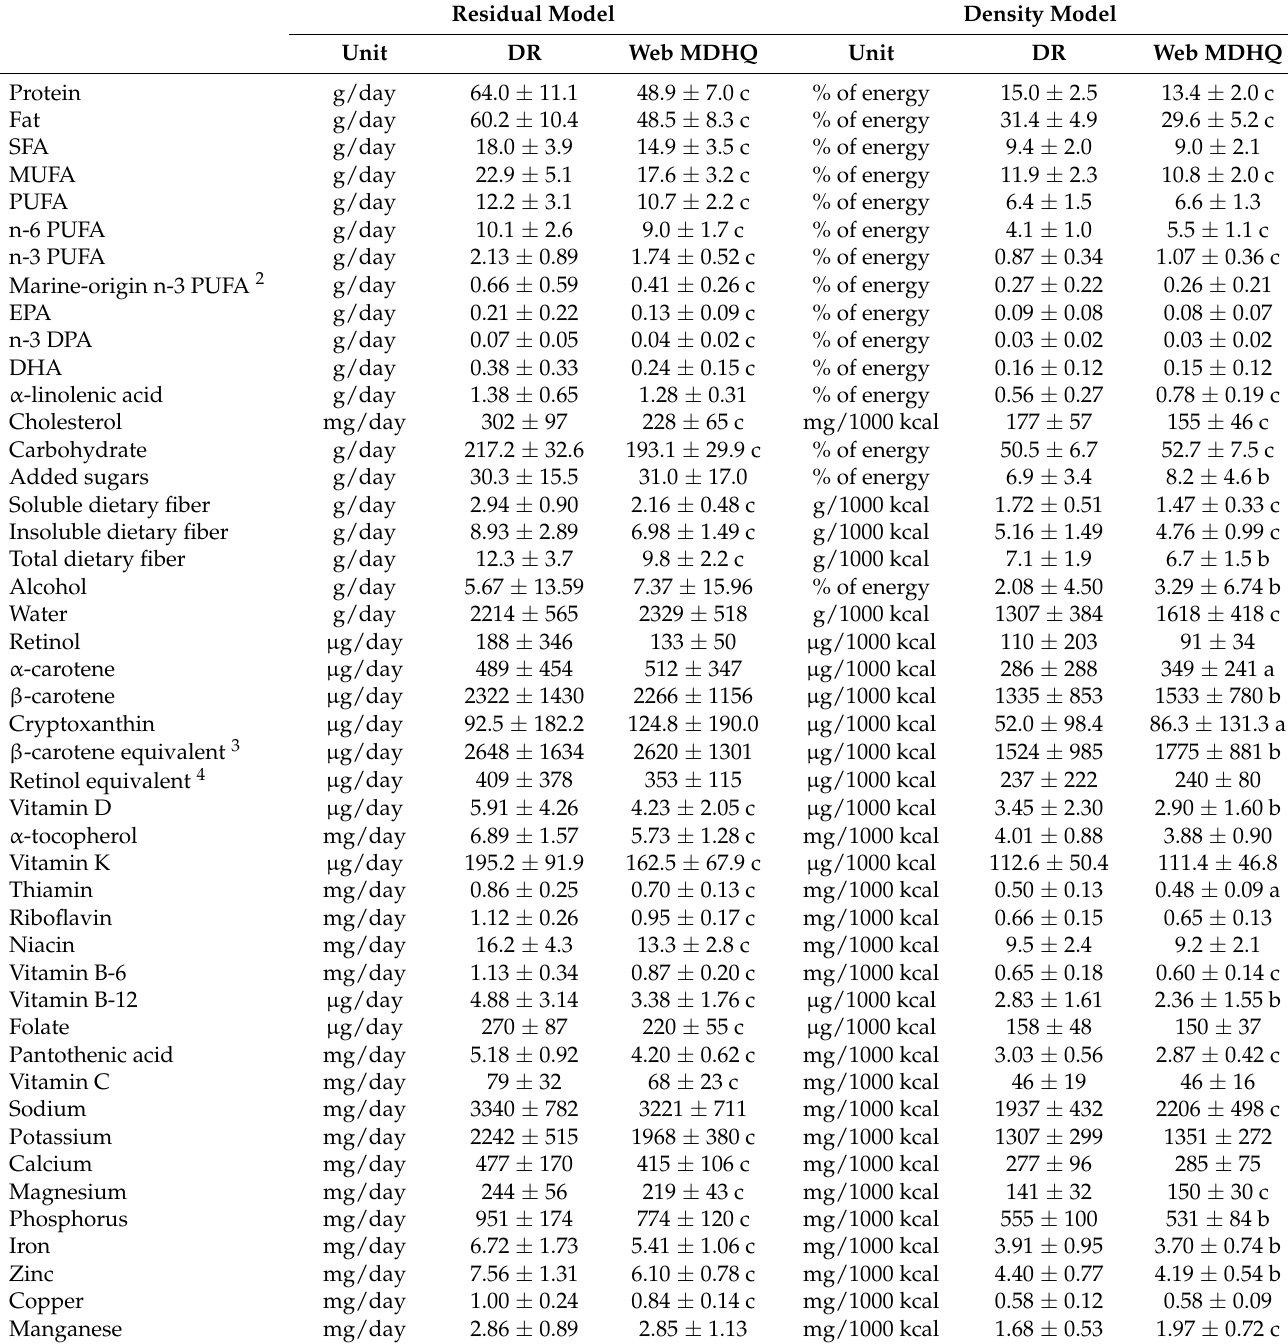
Table 2. Mean estimates of energy-adjusted intakes of nutrients obtained from the 4-day weighed dietary record (DR) and those obtained from the web version of the Meal-based Diet History Ques- tionnaire (MDHQ) in 111 Japanese women 1